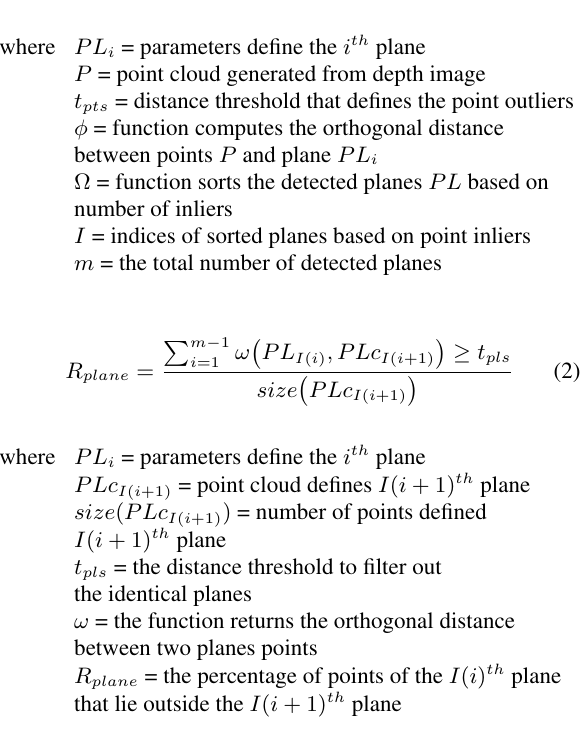
Figure 1. The proposed framework to reconstruct